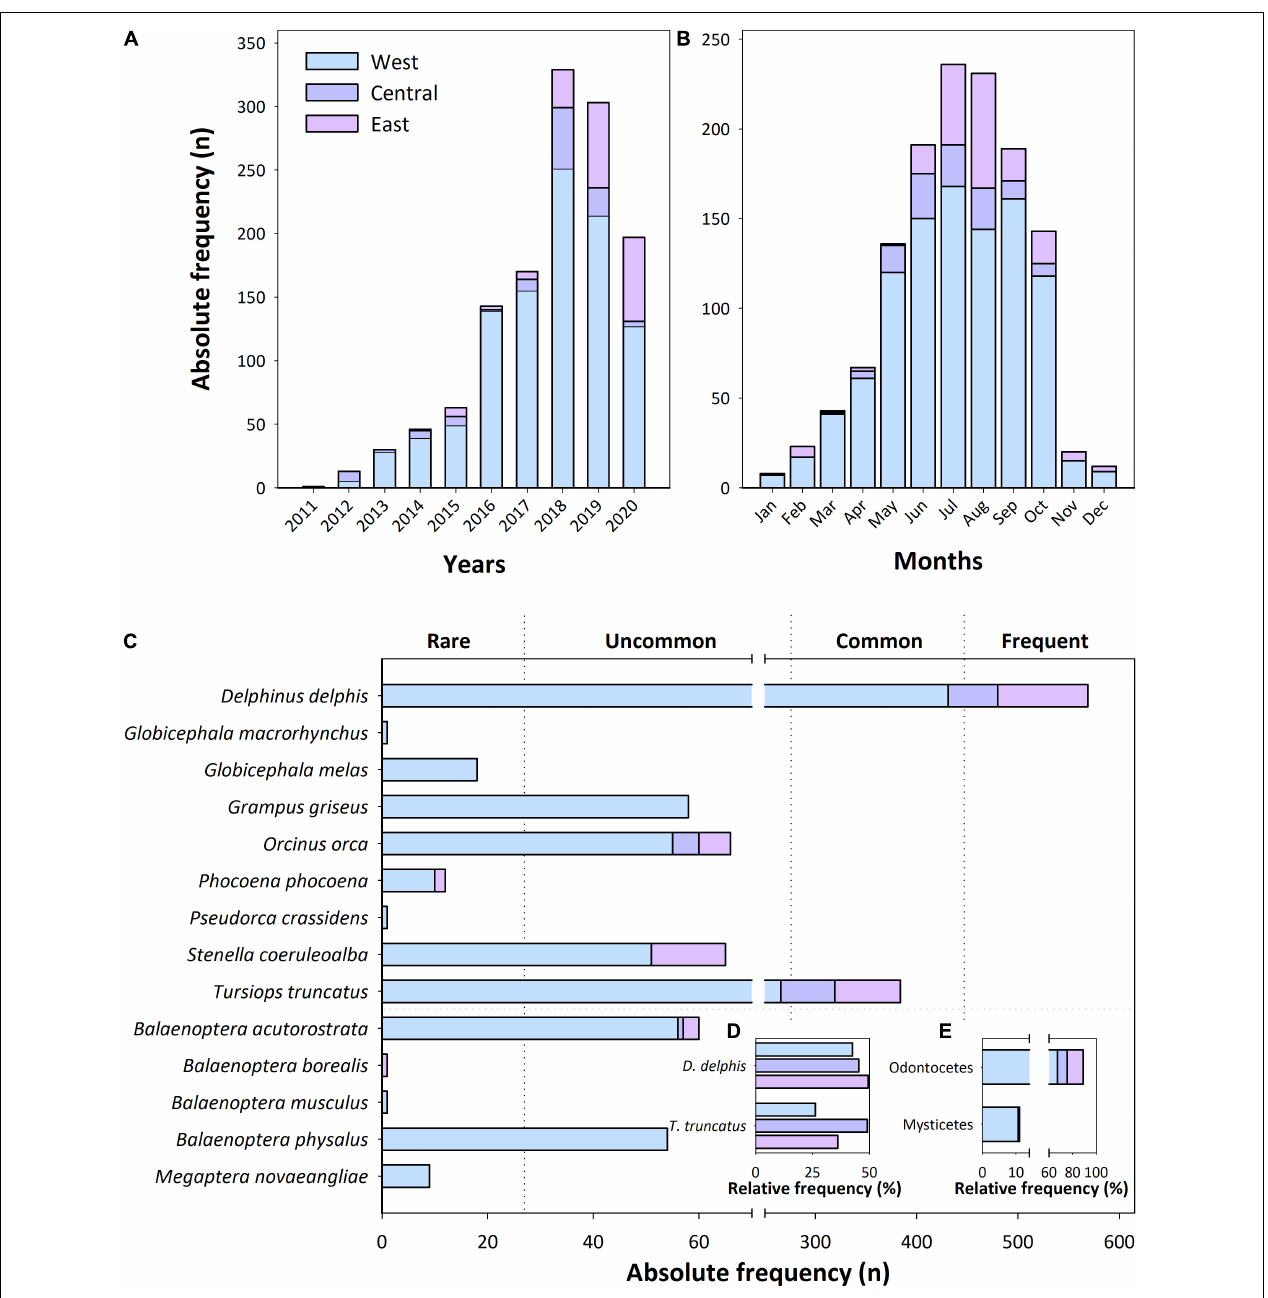
FIGURE 3 | Number of social media posts published between 2011 and 2020 by whale-watching companies from the Algarve (Portugal) by year (A) , month (B) , and species in each coastal area (west, central, east) (C) . The relative frequency of Delphinus delphis and Tursiops truncatus in each coastal area (D) , as well as of odontocetes and mysticetes (E) , are shown in the inset graphs. On (C) , the vertical dotted lines delimit the four levels of the Qualitative Commonness Index (QC Index, %) (rare, uncommon, common, and frequent), while the horizontal dotted line separates odontocetes (top) from mysticetes